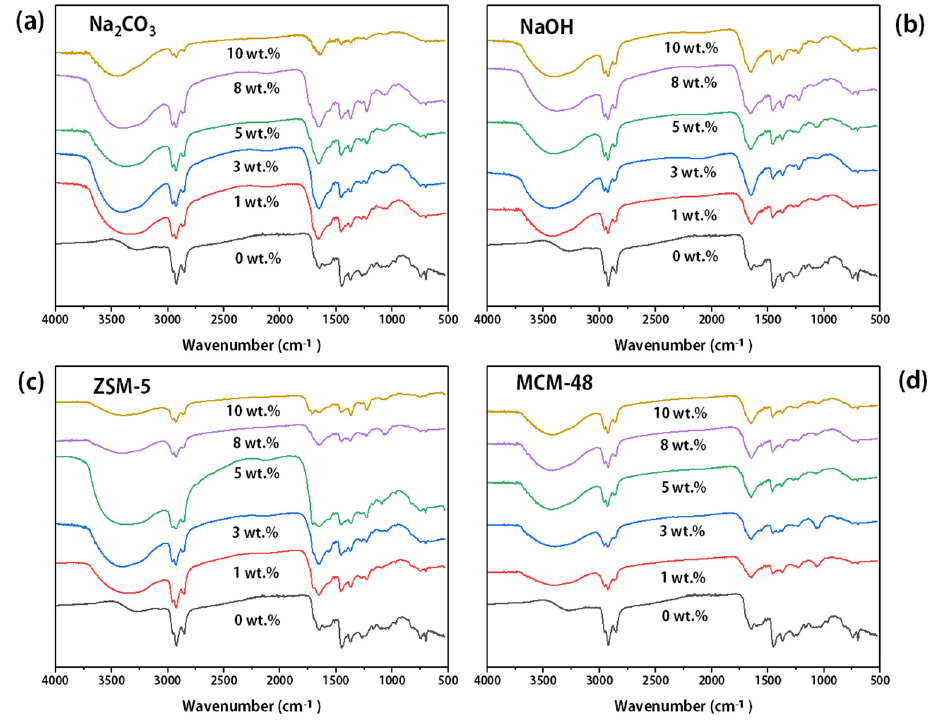
Figure 2. Effect of the catalyst dosage on the functional groups in bio-oil: ( a ) Na 2 CO 3 , ( b ) NaOH, ( c ) ZSM-5, ( d ) MCM-48. ( c ) ZSM-5, ( d )